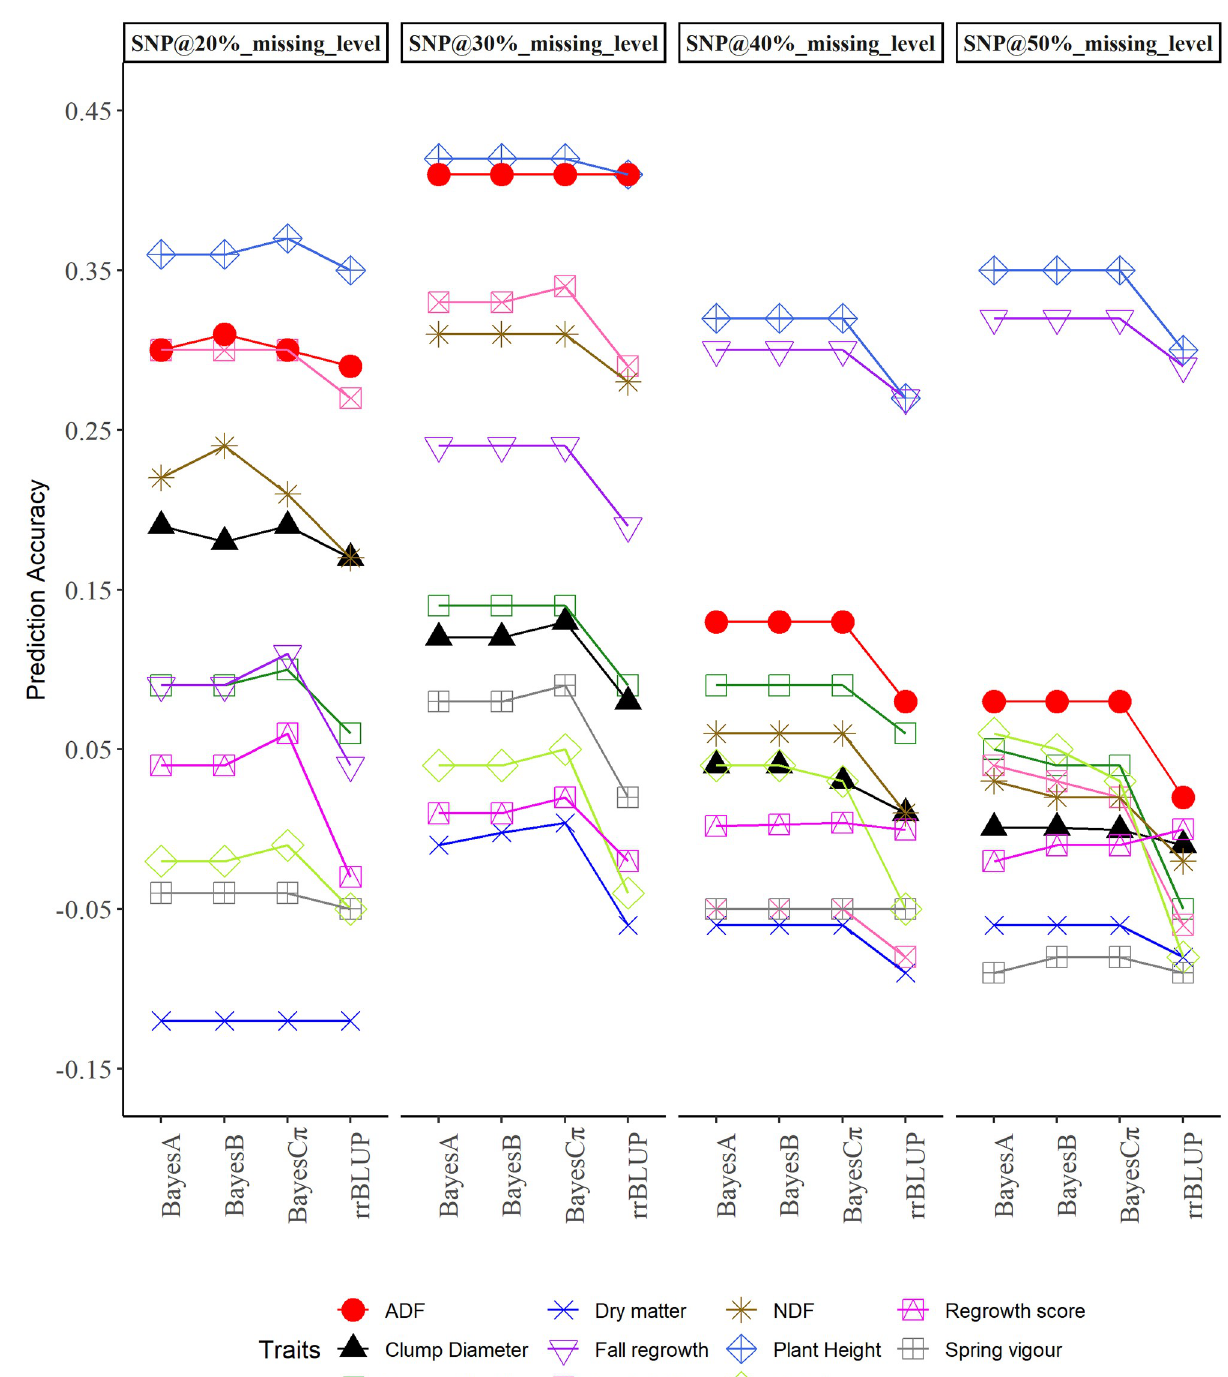
Fig 3. Prediction accuracy of four genomic selection models for genotypes evaluated at Swift Current, Canada.